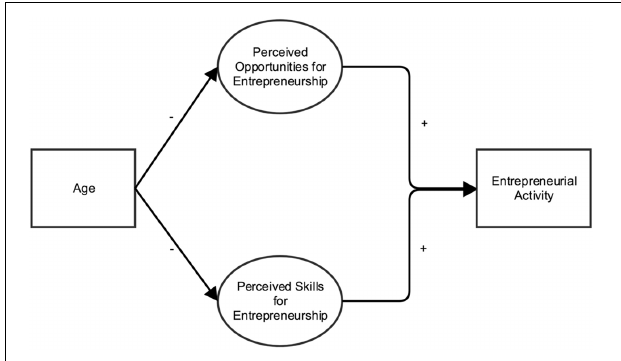
FIGURE 1 | Conceptual model of how age relates to entrepreneurial activity through perceived opportunities and perceived skills for